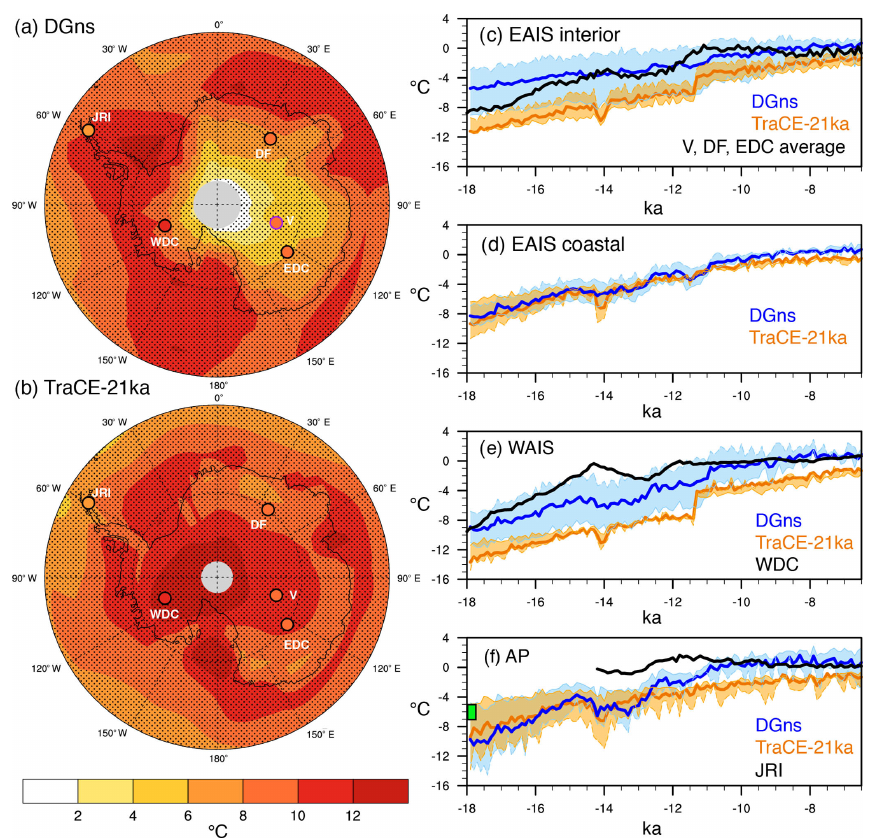
Figure 2. Surface temperature change ( ◦ C) as simulated in (a) DG ns and (b) TraCE-21ka for the period of 18 to 6.5ka (maximum latitude of 60 ◦ S). Dotted lines indicate latitude (intervals of 15 ◦ ) and longitude (intervals of 30 ◦ ). Ice core locations of the JRI, WDC, DF, V, and EDC sites are marked by filled circles, with the fill colour corresponding to the change estimated in the ice core record, black outlines indicating a match in warming between the ice core and model simulation (i.e. the ice core temperature change from 18 to 6.5ka is within the range of seasonal temperature changes of the climate model), and green (purple) outlines indicating an overestimation (underestimation) in warming by the models. For these model–proxy comparisons, we use site-specific model averages of land surface grid cells: JRI (63–65 ◦ S, 59–62 ◦ W), WDC (77–82 ◦ S, 115–109 ◦ W), DF (75–79 ◦ S, 36–42 ◦ E), V (77–82 ◦ S, 104–110 ◦ E), EDC (73–77 ◦ S, 121–127 ◦ E). Stippling indicates a difference between decadal output of 18.0–17.5 and 7.0–6.5ka that is significant at the 95% confidence level. (c–e) 100-year average surface temperature time series ( ◦ C) of four regions (EAIS interior: 83–75 ◦ S, 30 ◦ W–165 ◦ E; coastal EAIS: 75–68 ◦ S, 15 ◦ W–165 ◦ E; WAIS: 83– 72 ◦ S, 165 ◦ E–30 ◦ W; AP: 72–64 ◦ S, 64–59 ◦ W) relative to PI of both model simulations and ice core temperature reconstructions of sites located therein (DG ns in blue, TraCE-21ka in orange, ice cores in black). The coloured shading indicates the seasonal range calculated from the 100-year average austral summer and winter temperature anomalies. For EAIS, the ice core reconstruction is an average of the DF, V, and EDC sites. The green box in panel (f) indicates the LGM temperature anomaly estimated for JRI (6 . 01 ± 1 . 0 ◦ C; Mulvaney et al.,